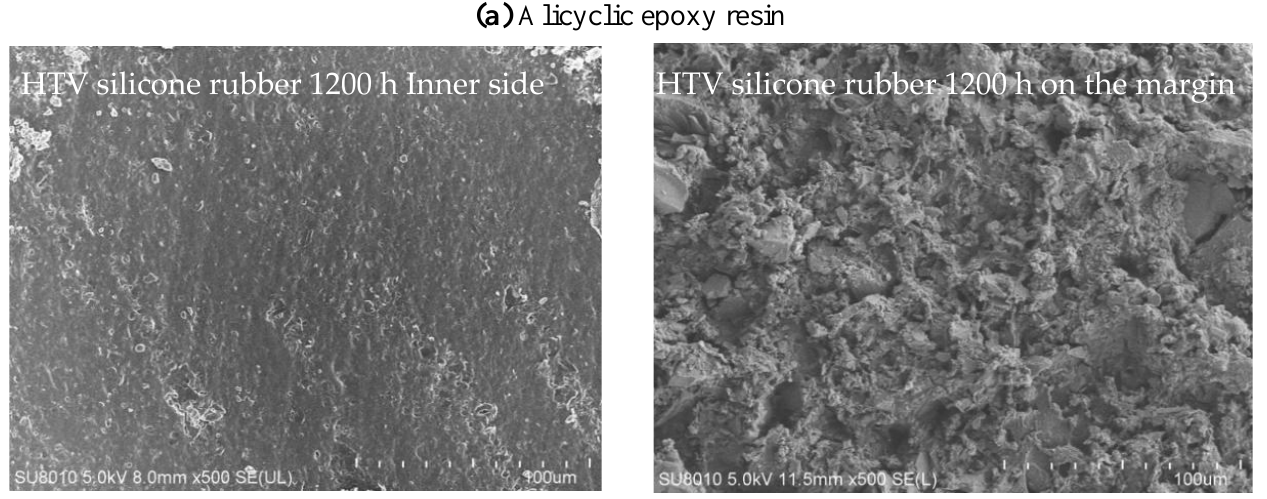
Figure 5. Cross-section images after 1200 h UV-A radiation: ( a ) Alicyclic epoxy resin; ( b ) HTV silicone rubber.